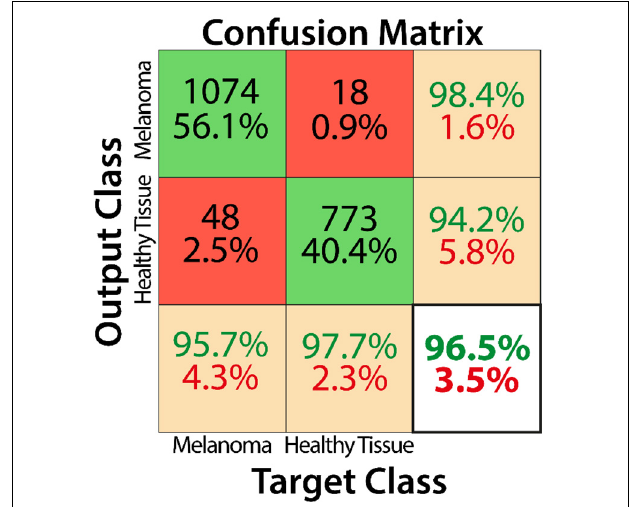
FIGURE 4 | Confusion matrix describing the classification performance of the trained CNN for the training